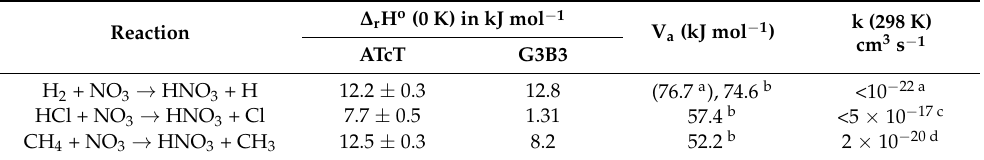
Table 2. Thermochemical values ( ∆ r H o ), energy barriers (V a ), and rate coefficients (k) for reactions (R4), (R5), and (R6).